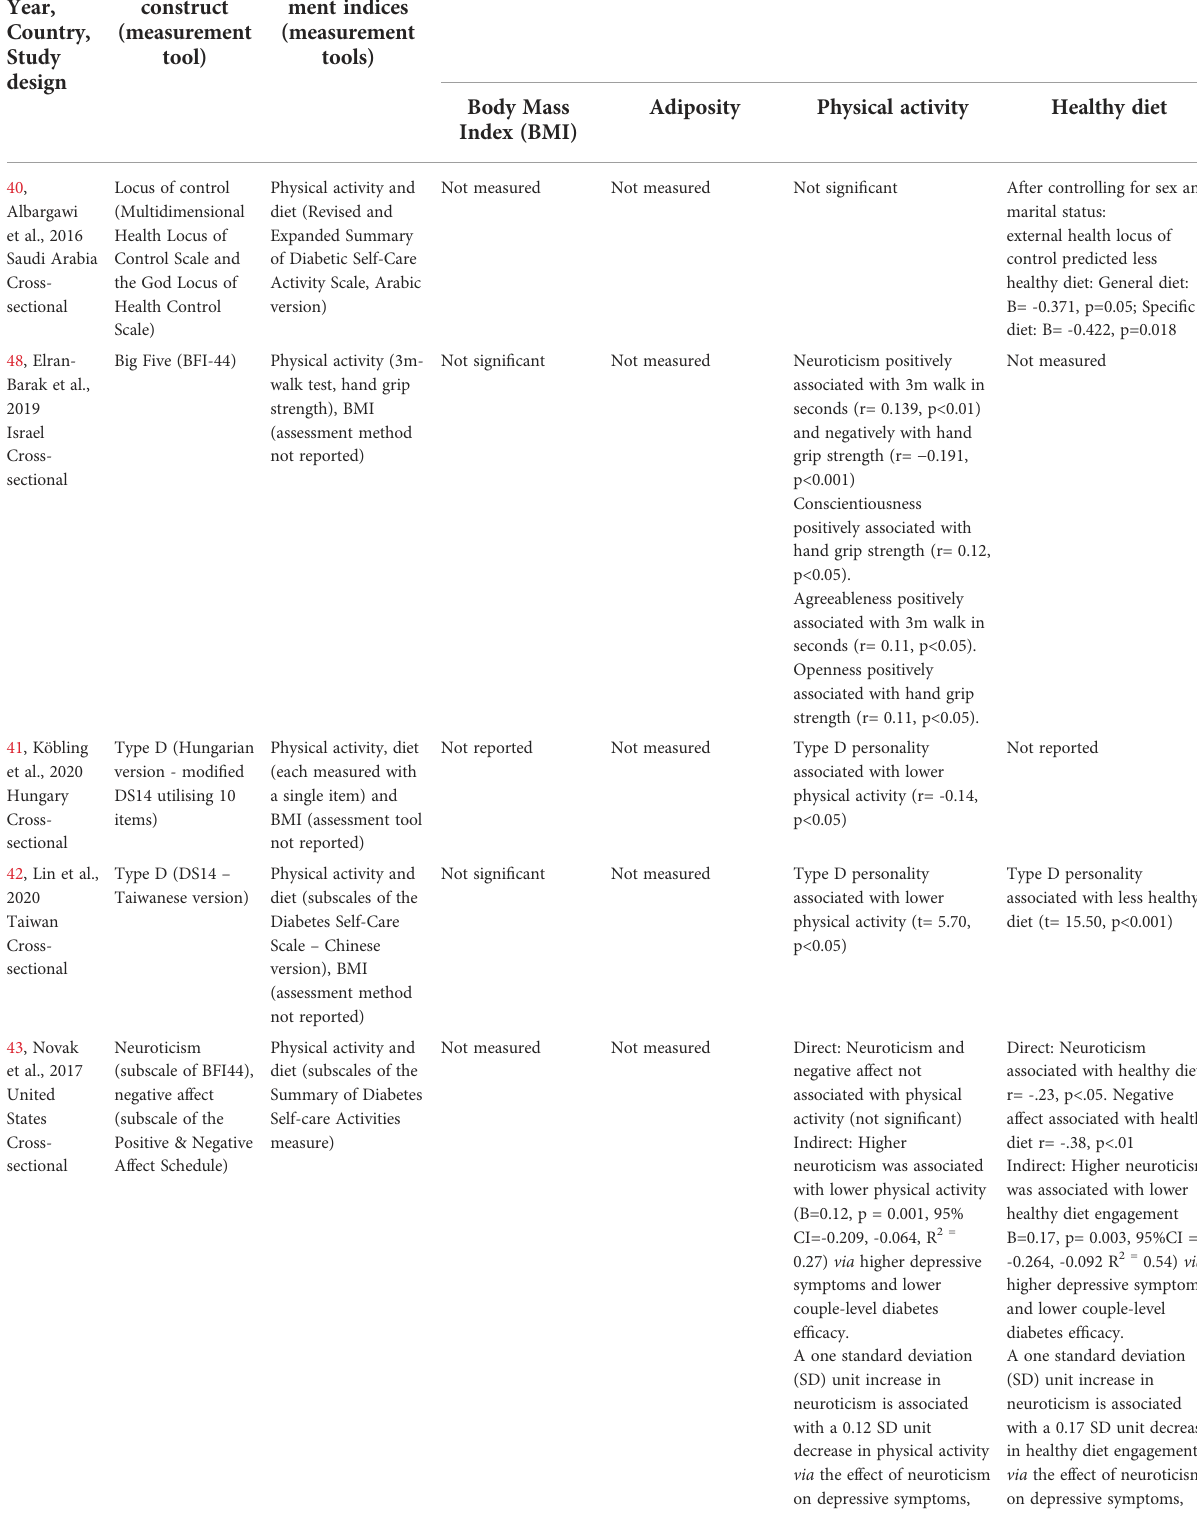
TABLE 2 Personality constructs, weight management indices and fi ndings by